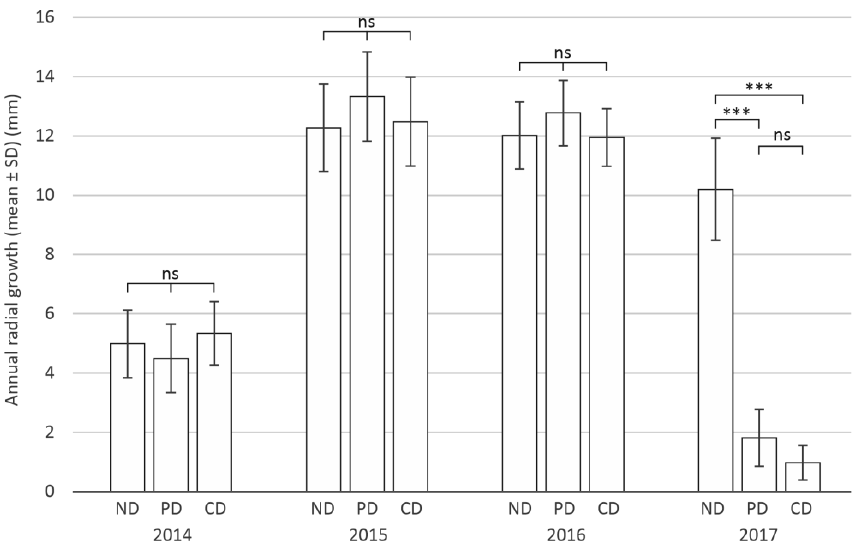
Table 2. Summary statistics for differences between annual radial growths depending on the defo- liation class (repeated measures ANOVA).